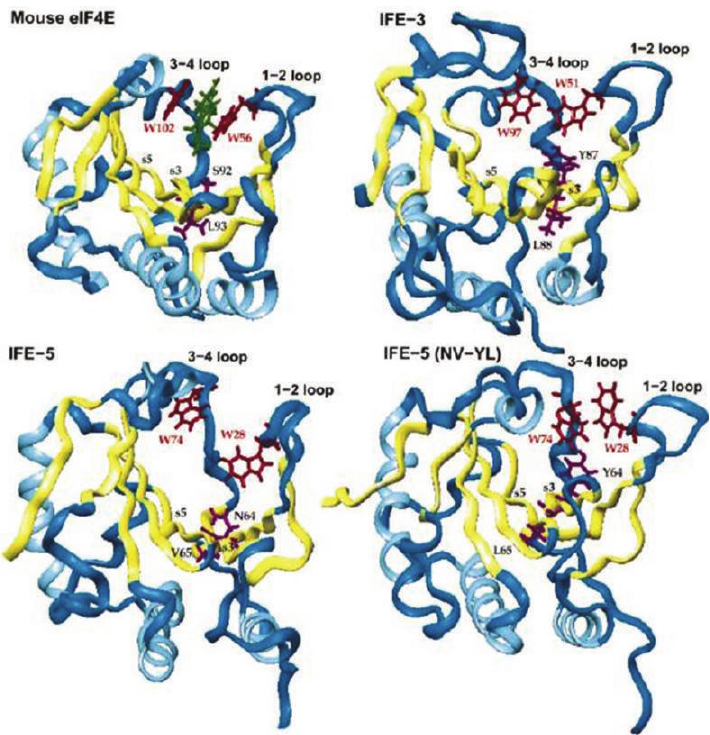
Figure 32: Molecular models of IFE-3, IFE-5, and IFE-5 (NV-YL) in comparison with mouse eIF4E [85]. The di ff erences between the m 7 G cap binding pocket and m 32,2,7 G cap binding pocket are illustrated by di ff erences in the 3-4 loop configuration.